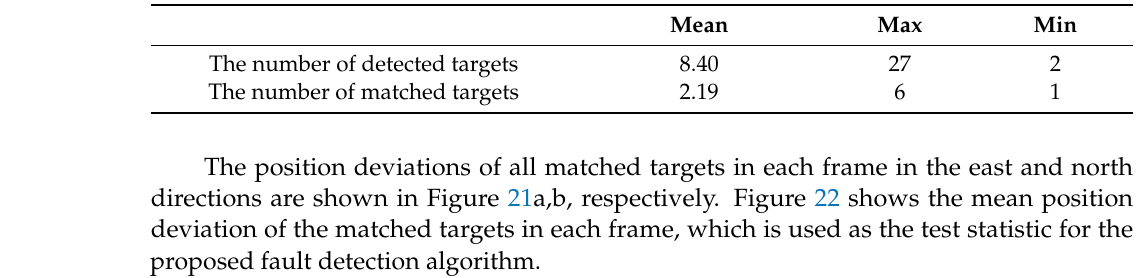
Figure 20. Matched targets between the single frame and map-based target detection results. ( a ) The No. 0–25 of matched targets for target detection in the global map. ( b ) The number of detected and matched targets in each frame. Table 5. The number of detected targets and matched targets.